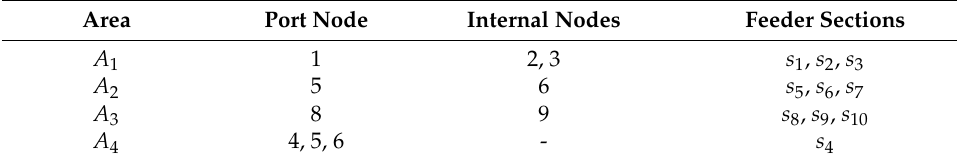
Figure 3. Area division results of a typical distribution network. Table 2. Nodes and feeder sections contained in the area.